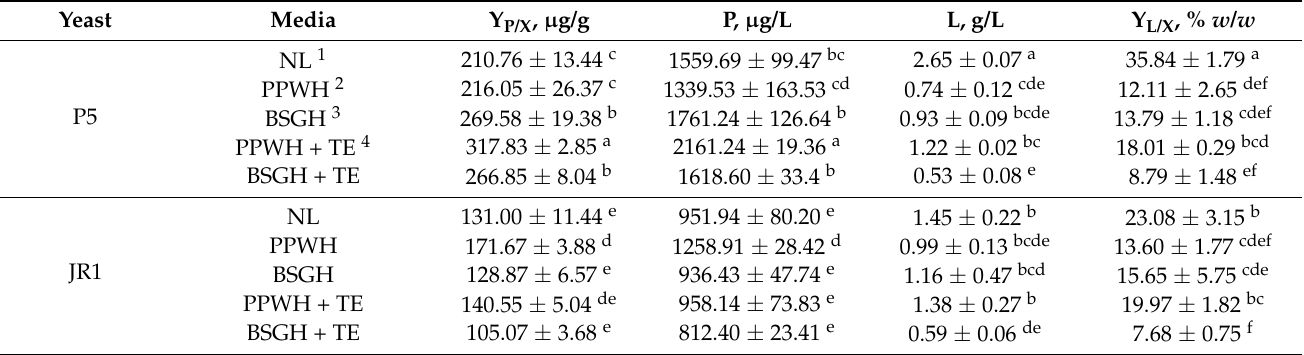
Table 4. Microbial oil and carotenoid production by P5 and JR1 strains in nitrogen-limited media and hydrolysates